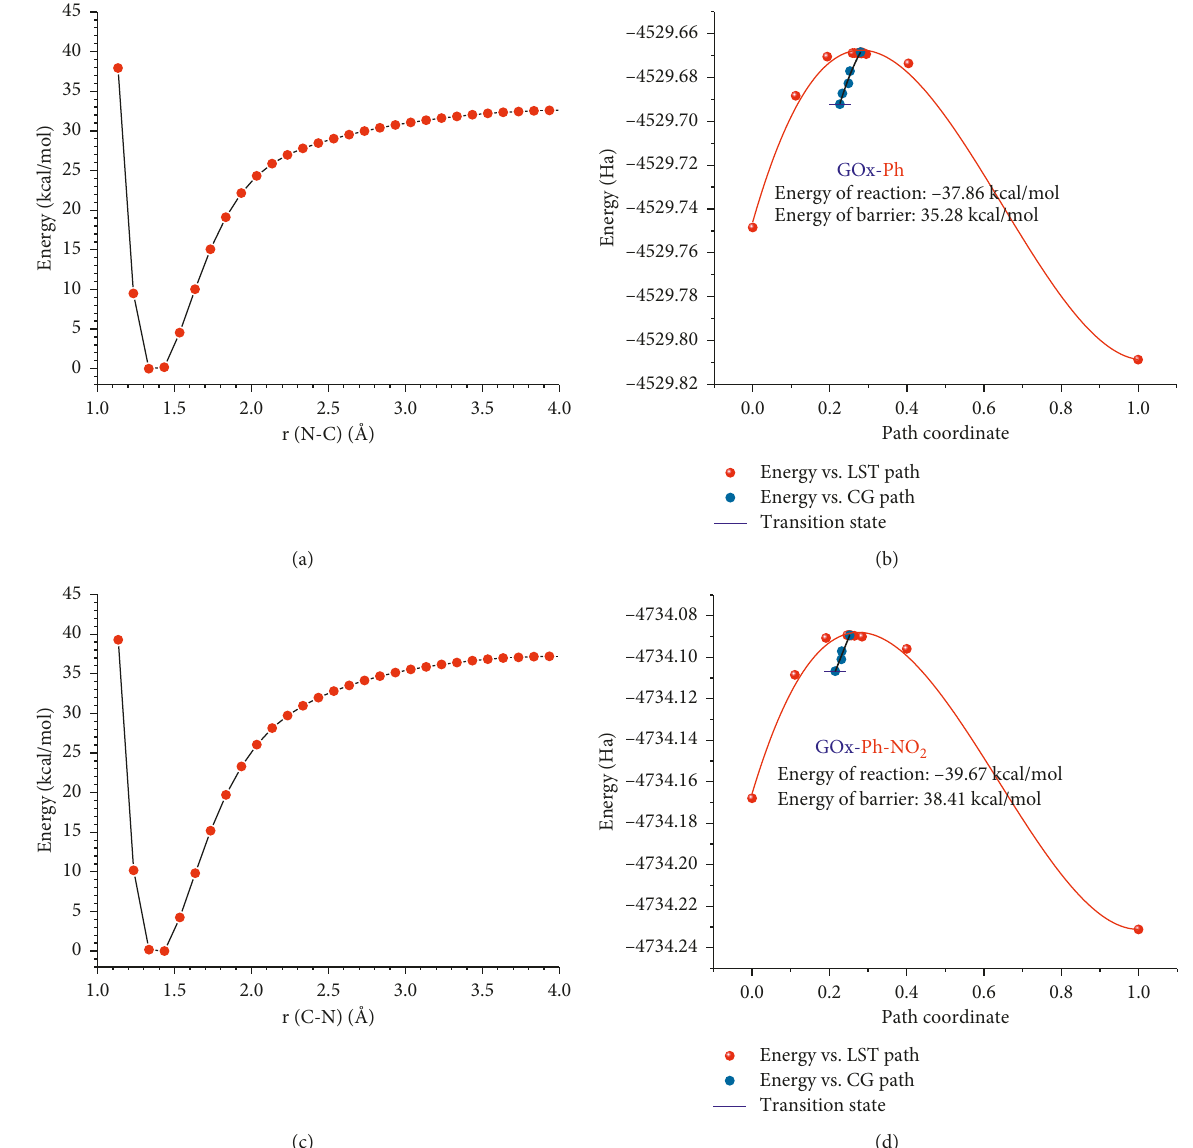
Figure 4: Graph of homolytic BDE of (a) phenyldiazonium and (b) nitrophenyldiazonium cations together with the corresponding TS search energy trajectories for the grafting reaction of (c) phenyl radicals and (d) nitrophenyl radicals onto the graphene oxide